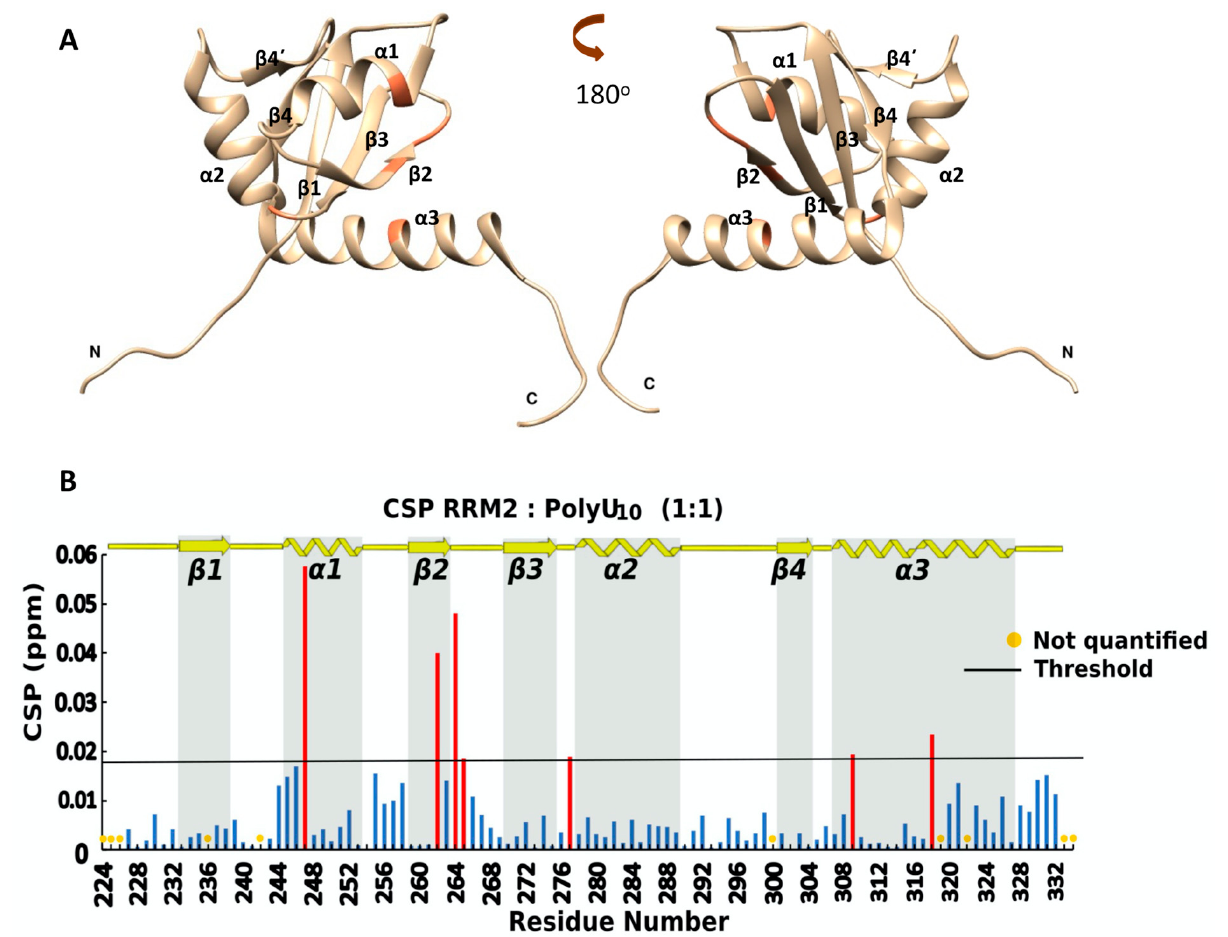
Figure 6. ( A ) Ribbon representation of the affected amino acids mapped (in orange) into the hRRM2 structure (PDB ID:1OWX); ( B ) chemical shift perturbation of 15 N-hRRM2 upon the addition of the unlabeled ligand in threshold value 0.018. Red bars indicate CSPs above threshold, while blue bars illustrate CSPs beyond threshold line.